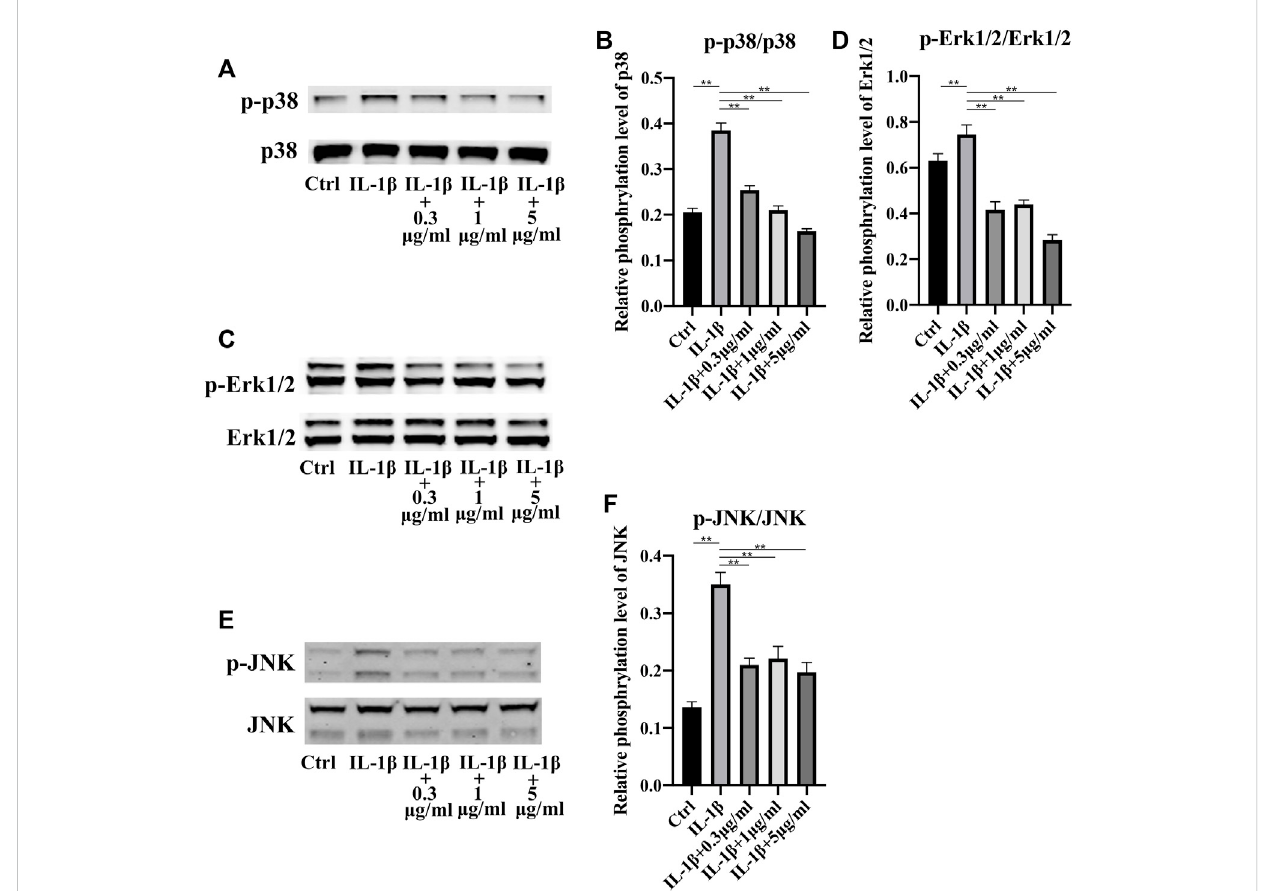
FIGURE 5 Expression ofMAPK signalingpathwayafter IL-1 β (50 ng/mL) and fullerenol(0.3,1,5 μ g/mL) treatment. (A) The phosphorylationlevels ofp38in TCs of Ctrl, IL-1 β , IL-1 β +0.3 μ g/mL, IL-1 β +1 μ g/mL, IL-1 β +5 μ g/mL groups were examined by Western Blotting. (B) Quantitative results of phosphorylation levels of p38. (C) The phosphorylation levels of Erk1/2 in TCs of Ctrl, IL-1 β , IL-1 β +0.3 μ g/mL, IL-1 β +1 μ g/mL, IL-1 β +5 μ g/mL groups were examined by Western Blotting. (D) Quantitative results of phosphorylation levels of Erk1/2. (E) The phosphorylation levels of JNK in TCs of Ctrl, IL-1 β , IL-1